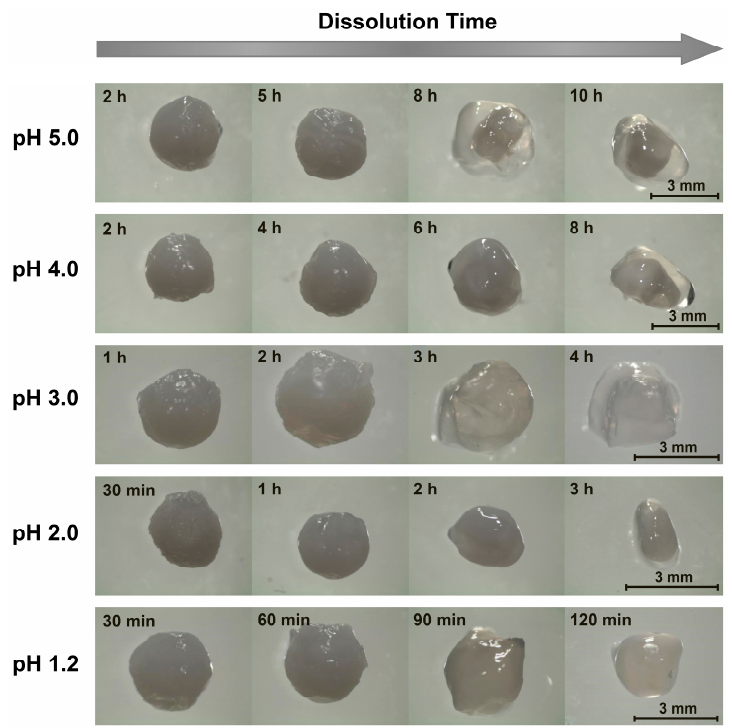
Figure 5. Representative images of chitosan/NaC 10 beads dissolving in pH 1.2–5.0 aqueous solutions ([NaCl] = 10 mM).